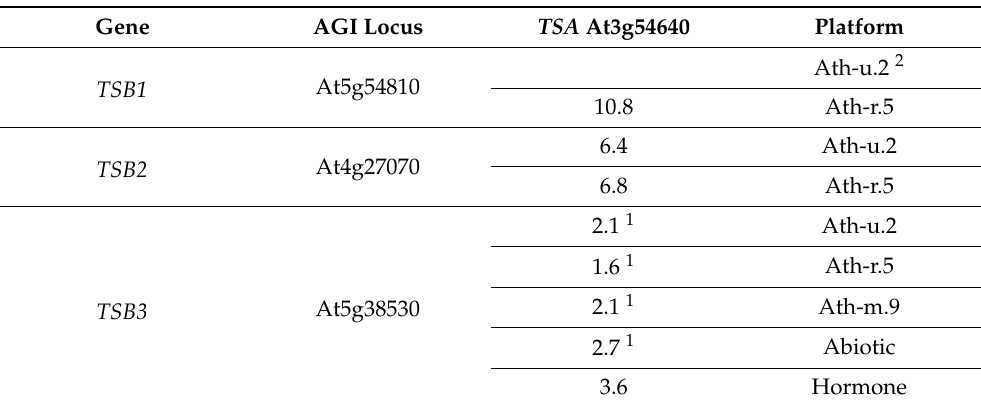
Table 2. Coexpression of TSA with TSB1 , TSB2 , TSB3 , and TSB4 under general and specific condi- tions. Coexpression is supported by the latest release of RNA sequencing (Ath-r.5) and microarray data (Ath-m.9). Logit Score (LS) was used as a coexpression index. Higher LS indicates a better coexpression performance. TSA ; tryptophan synthase A , TSB ; tryptophan synthase B . Specific